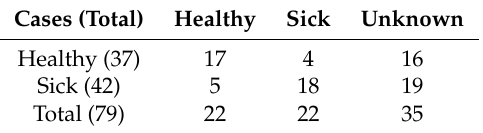
Table 2. Comparison of the results using the Database for Mastology Research